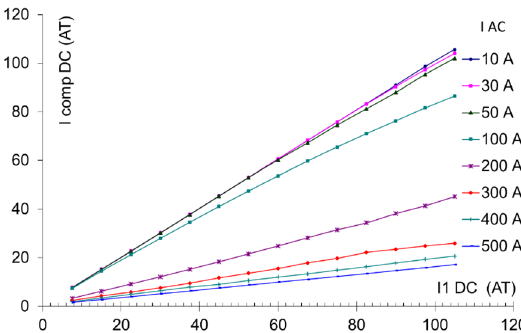
Figure 6. Closed-loop response to DC current I 1DC; AC measured current I 1AC is a parameter. Tested